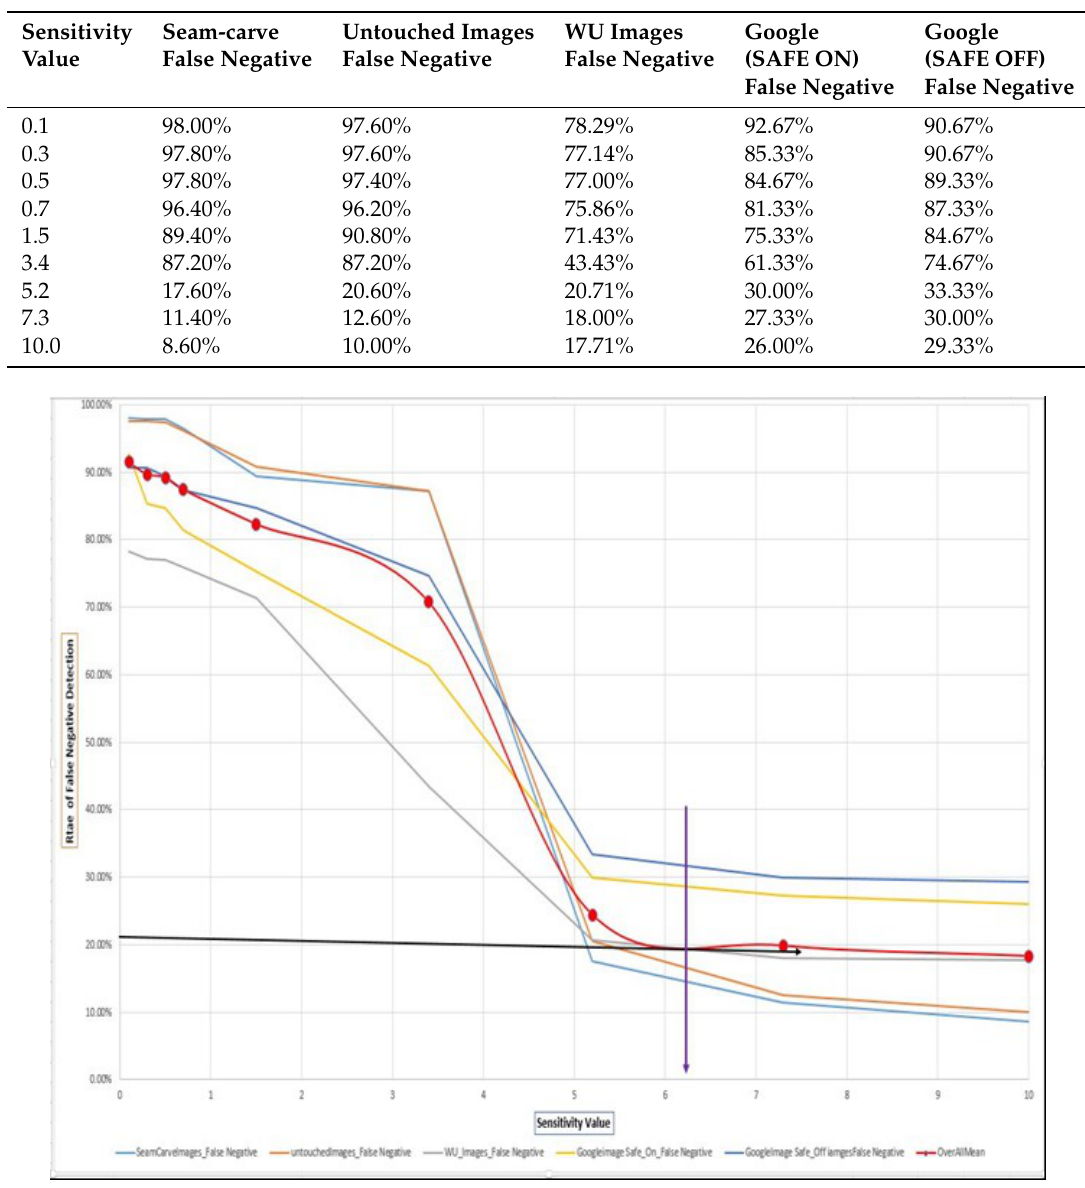
Table 7. Overall false negative rates of ALL the different image databases with different sensitivity values.